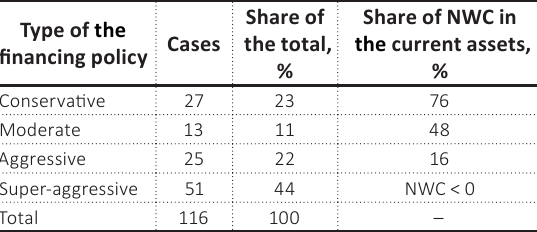
Table 2. The distribution of cases by the type of financing policy